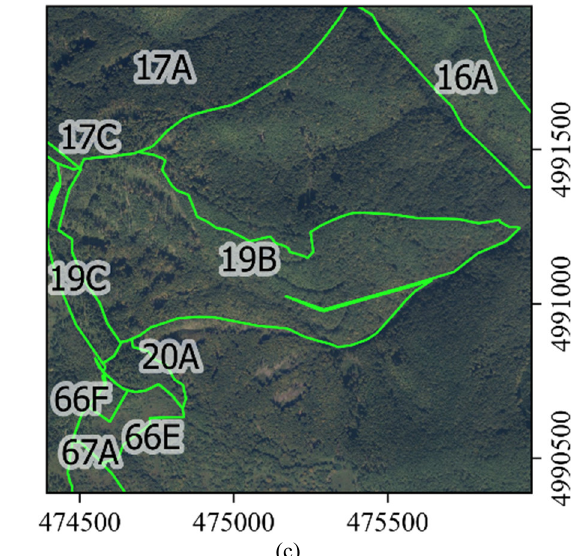
Figure 1 . Study area and example subsets (a) forest compartments/subcompartments 17A (b) and 19B (c). Base map is a digital orthophoto map (DOF) from State geodetic administration